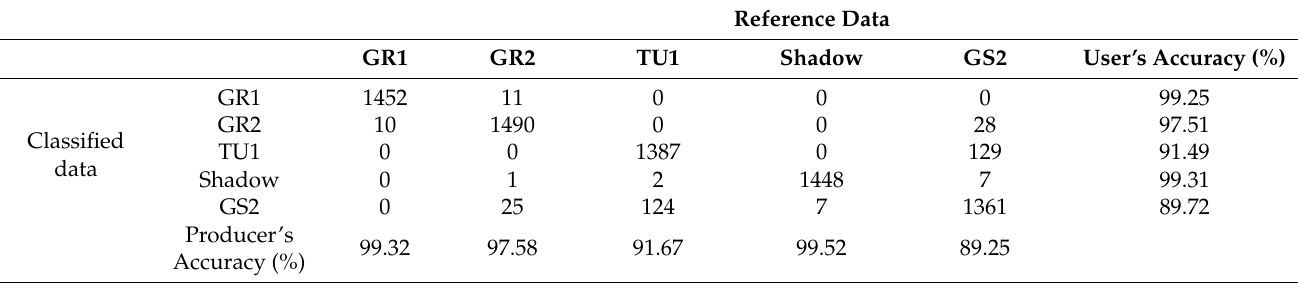
Figure 2. The classification map of fuel types for the study area. GR1 and GR2 represent Grass Fuel Type Models, GS2 represents Grass-Shrub Fuel Type Model, and TU1 represents Timber-Understory Fuel Type Model. Table 3. Classification error matrix for fuel type